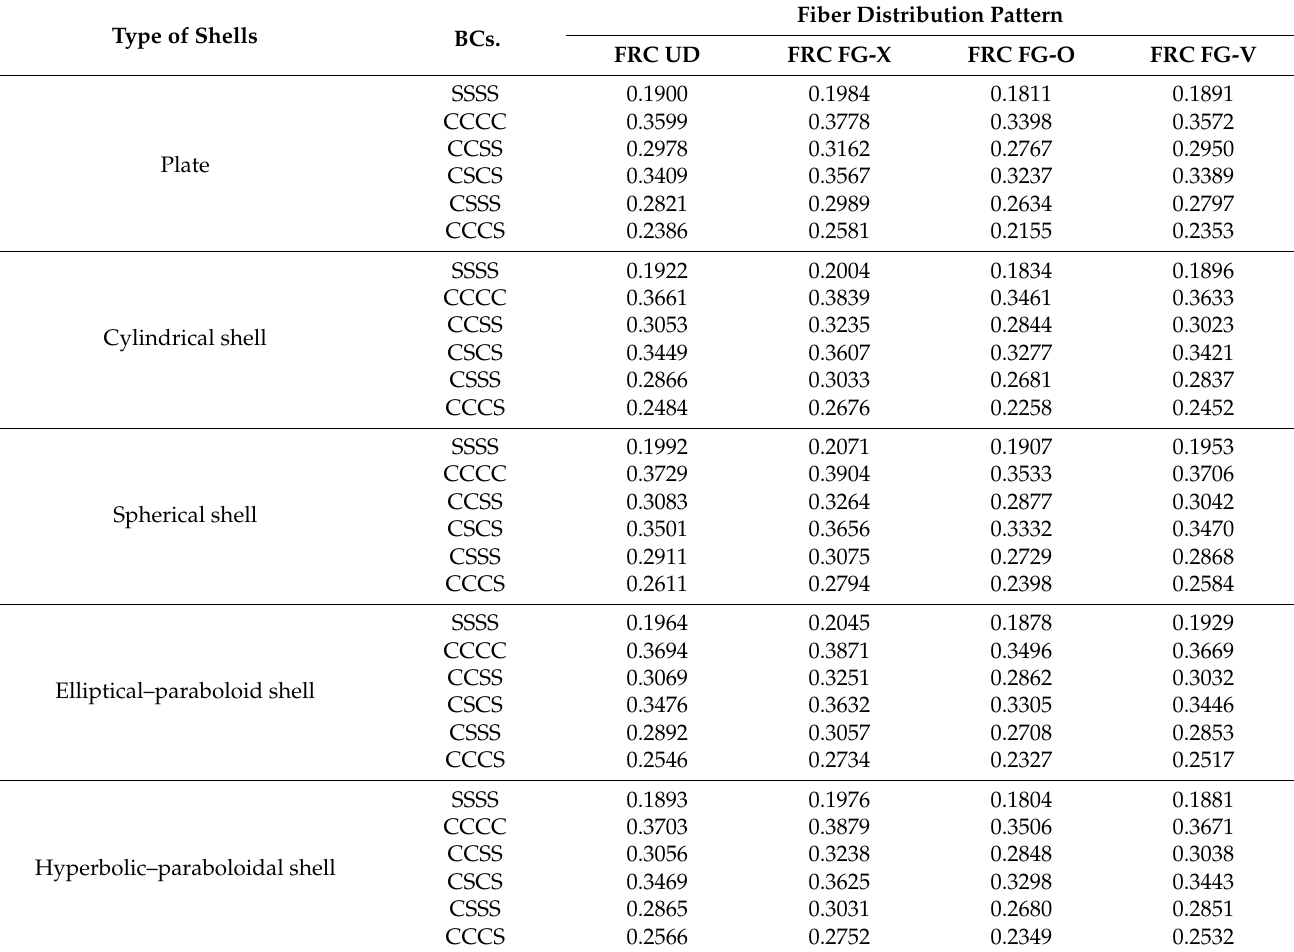
Table 9. The effect of different boundary conditions and fiber distribution patterns on the dimension- less frequency of cross-ply F/CNT-RC shells ( b / a = 1, N = 9, a / h = 10, V cnt = 0.01, V f max = 0.3, = V f min